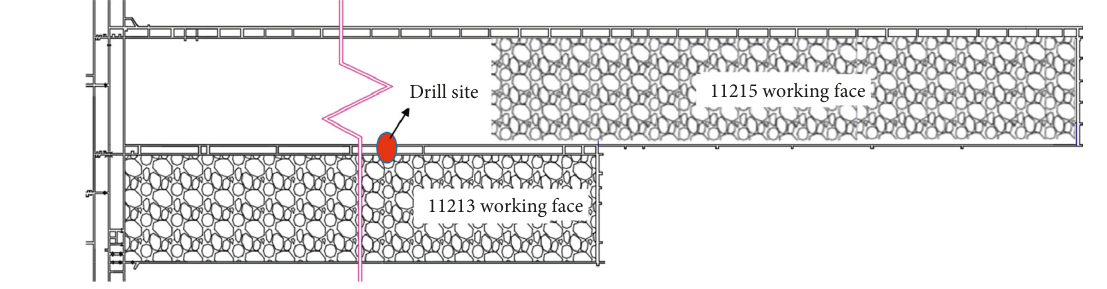
Figure 11: Location map of No. 11215 working face. Table 3: Construction parameters of borehole